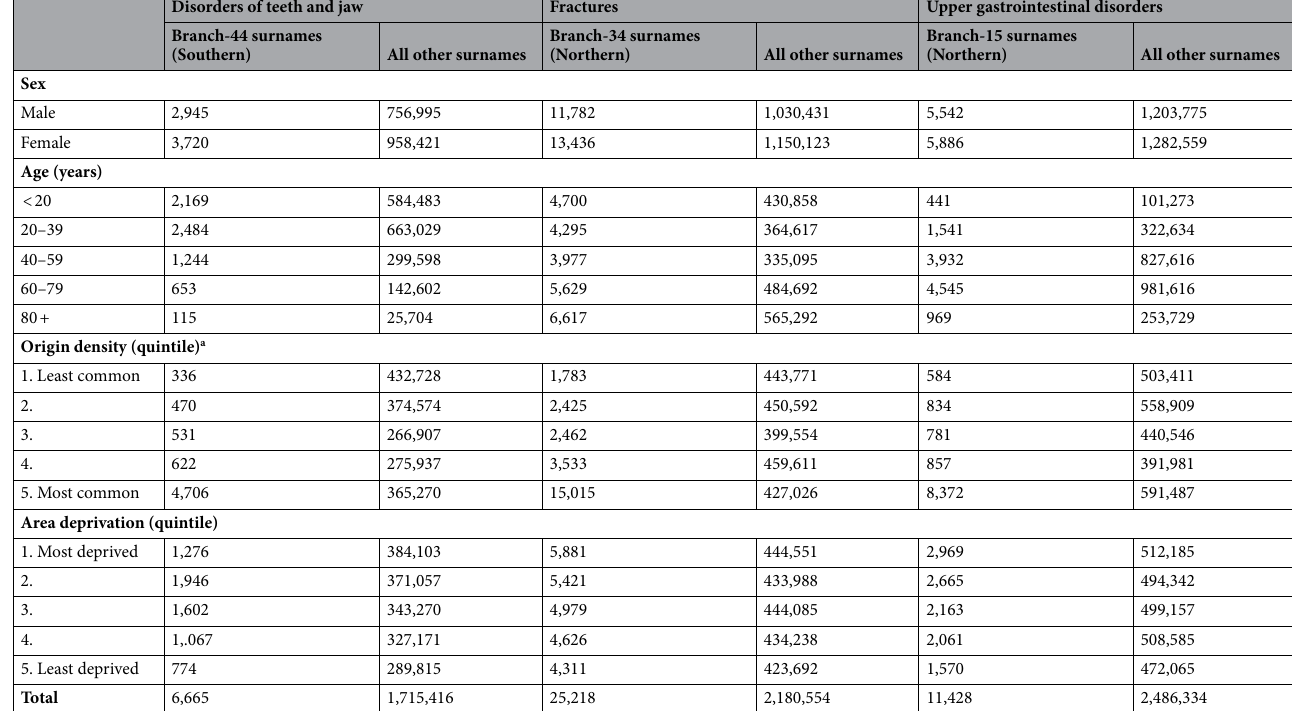
Table 2. Patient characteristics by signal (disease category-surname origin) and totals in number of patients. First admission per patient per disease group by British surname origin status for each signal in Hospital Episode Statistics (HES) in England between 1999 and